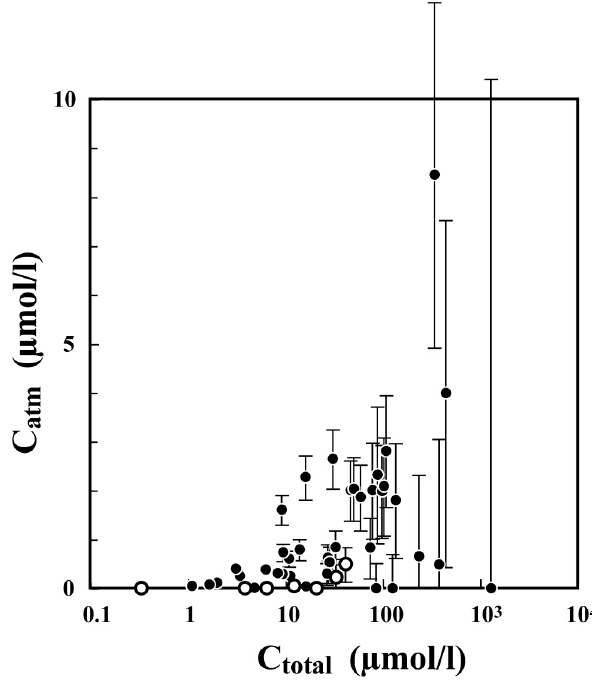
Fig. 4. Calculated concentration of NO − ter sample plotted as a function of the total NO − (C total ) . Open circles denote those showing δ 15 N values of more than + 11‰. Error bars smaller than the symbols were